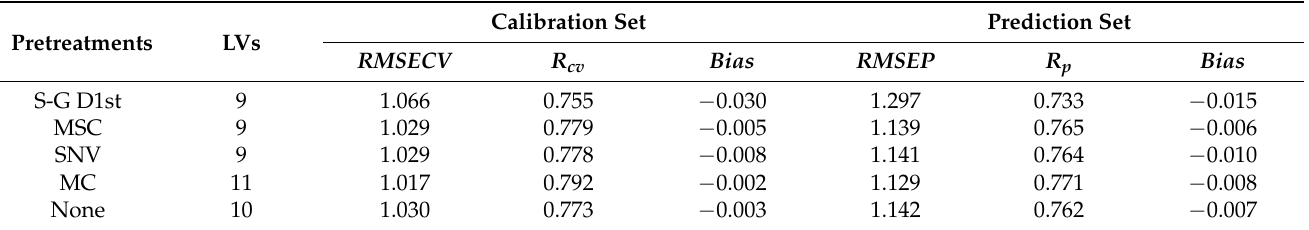
Table 2. Comparison of pretreatments on the predictive performance of the developed PLS model.